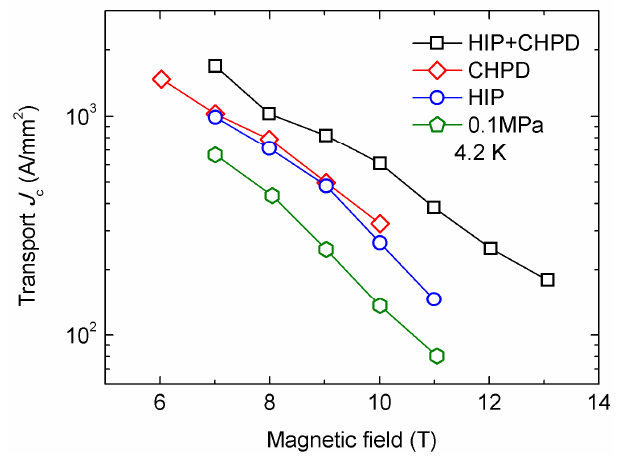
Figure 9. Transport J c of the MgB 2 samples heat-treated by HIP (1.4 GPa) + CHPD (1.8 GPa), CHPD (1.8 GPa), and HIP (1.4 GPa), as well as samples fabricated under 0.1 MPa. Some data are based on